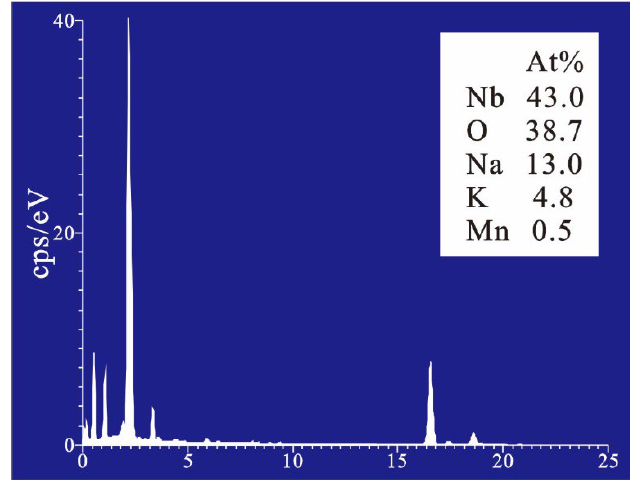
Figure 6. X-ray energy spectrum analysis of KNMN coating.